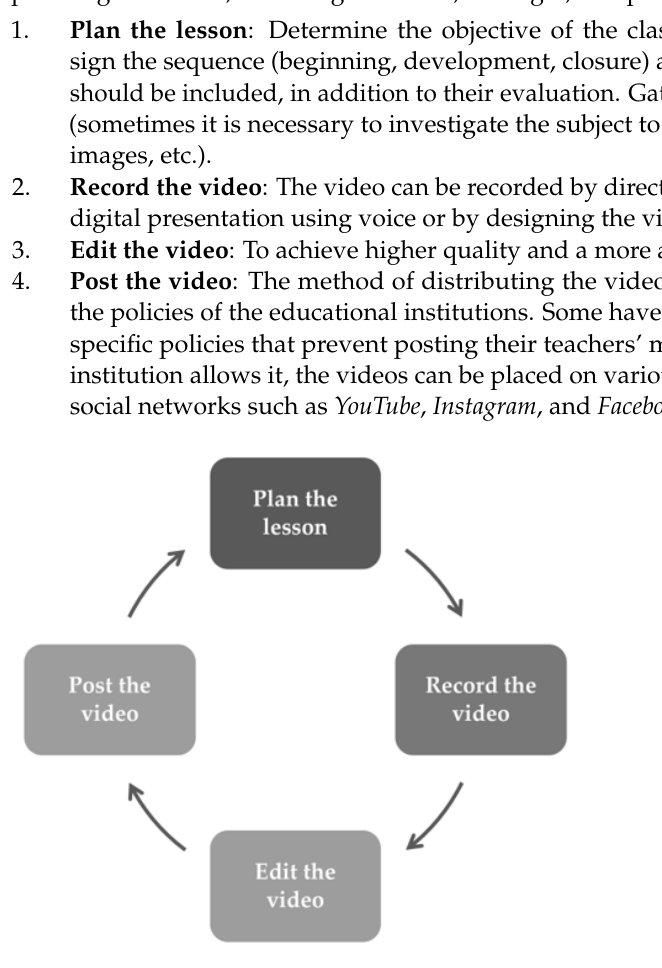
Figure 2. The process of planning a class under the Flipped Classroom model using videos.